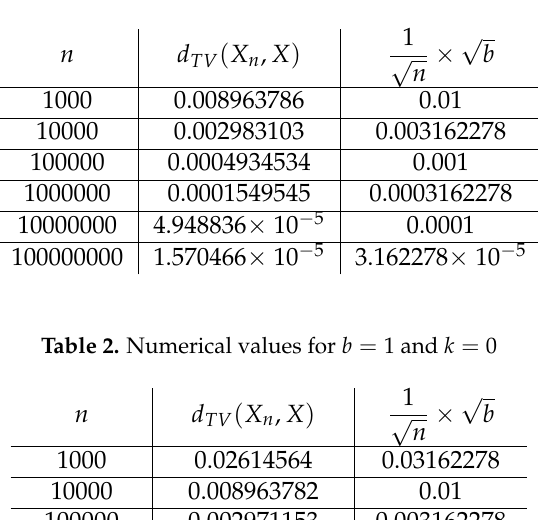
Table 1. Numerical values for b = 0.1 and k = 0